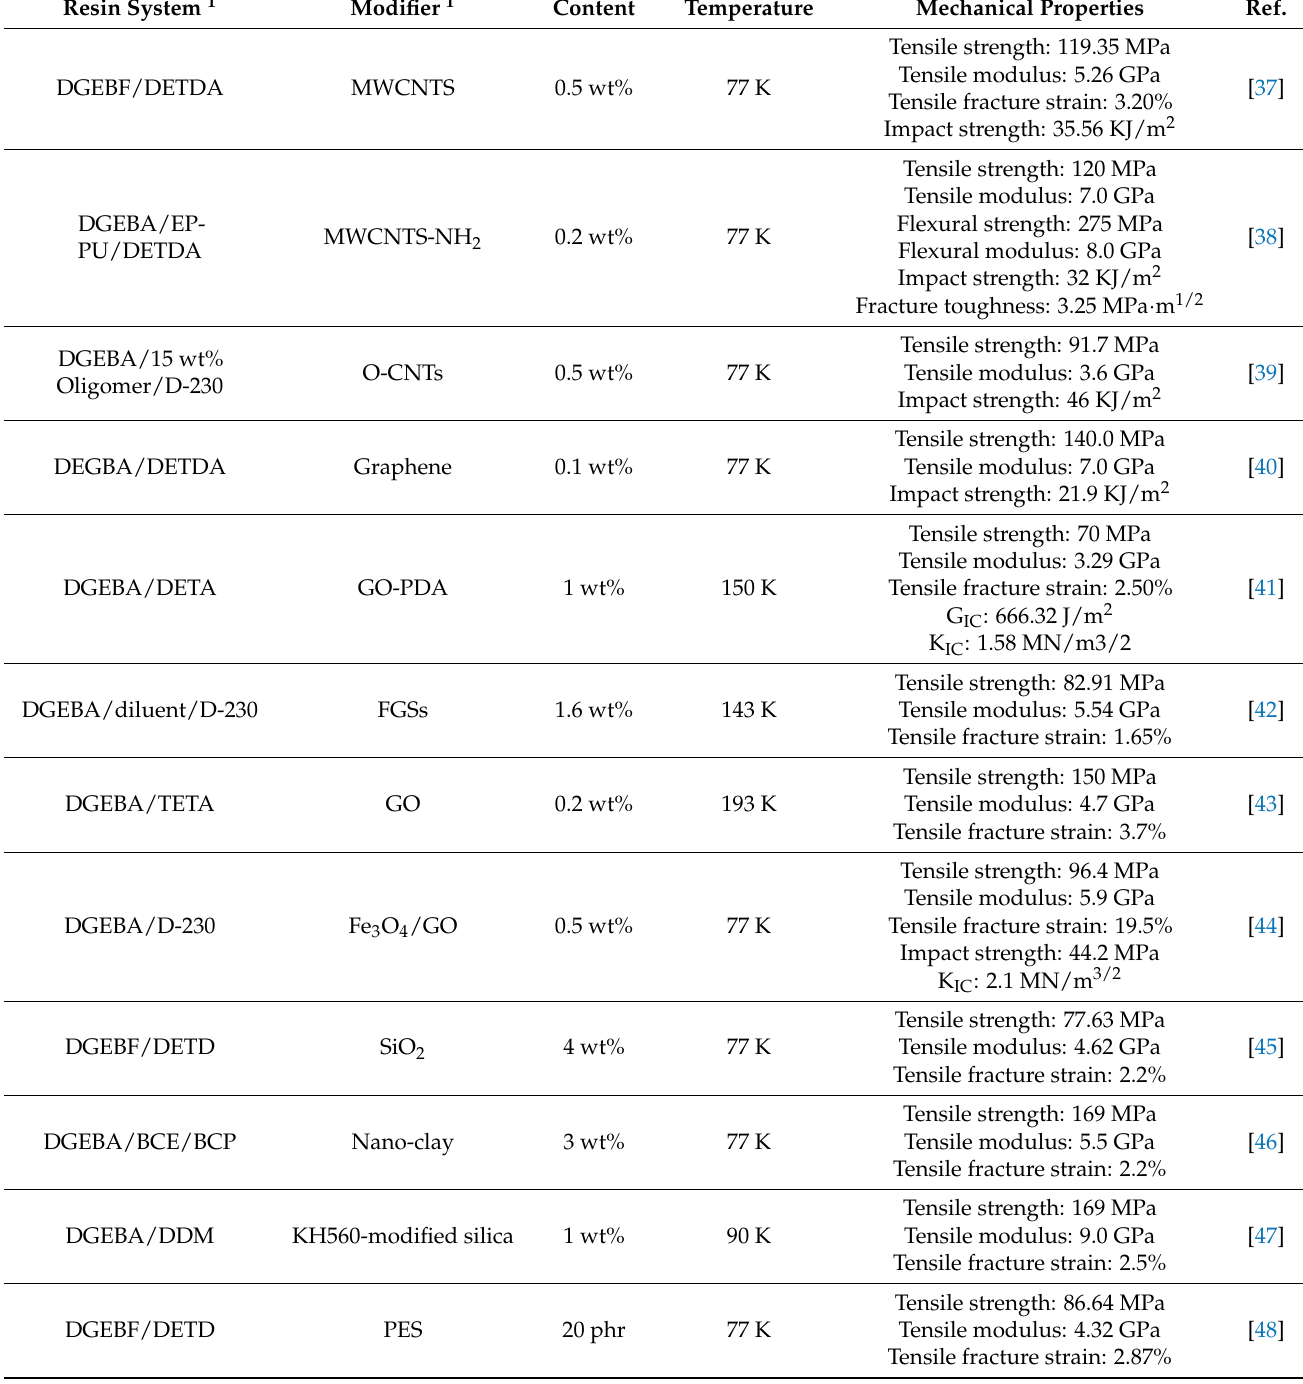
Table 1. Cryogenic mechanical properties of modified thermoset